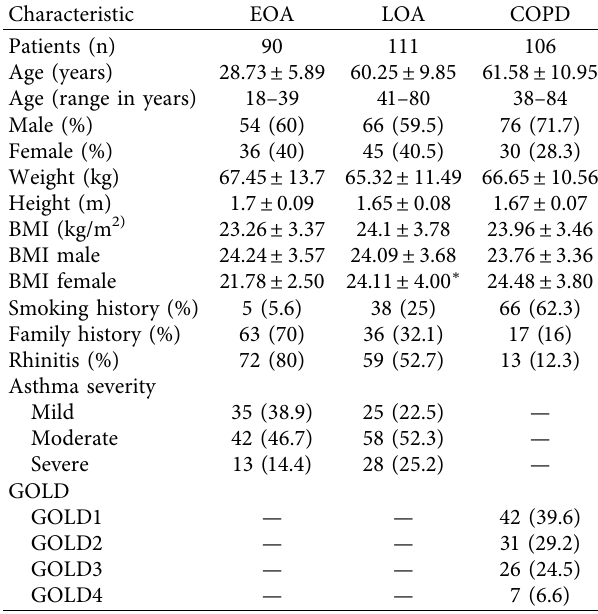
Table 1: Patient clinical